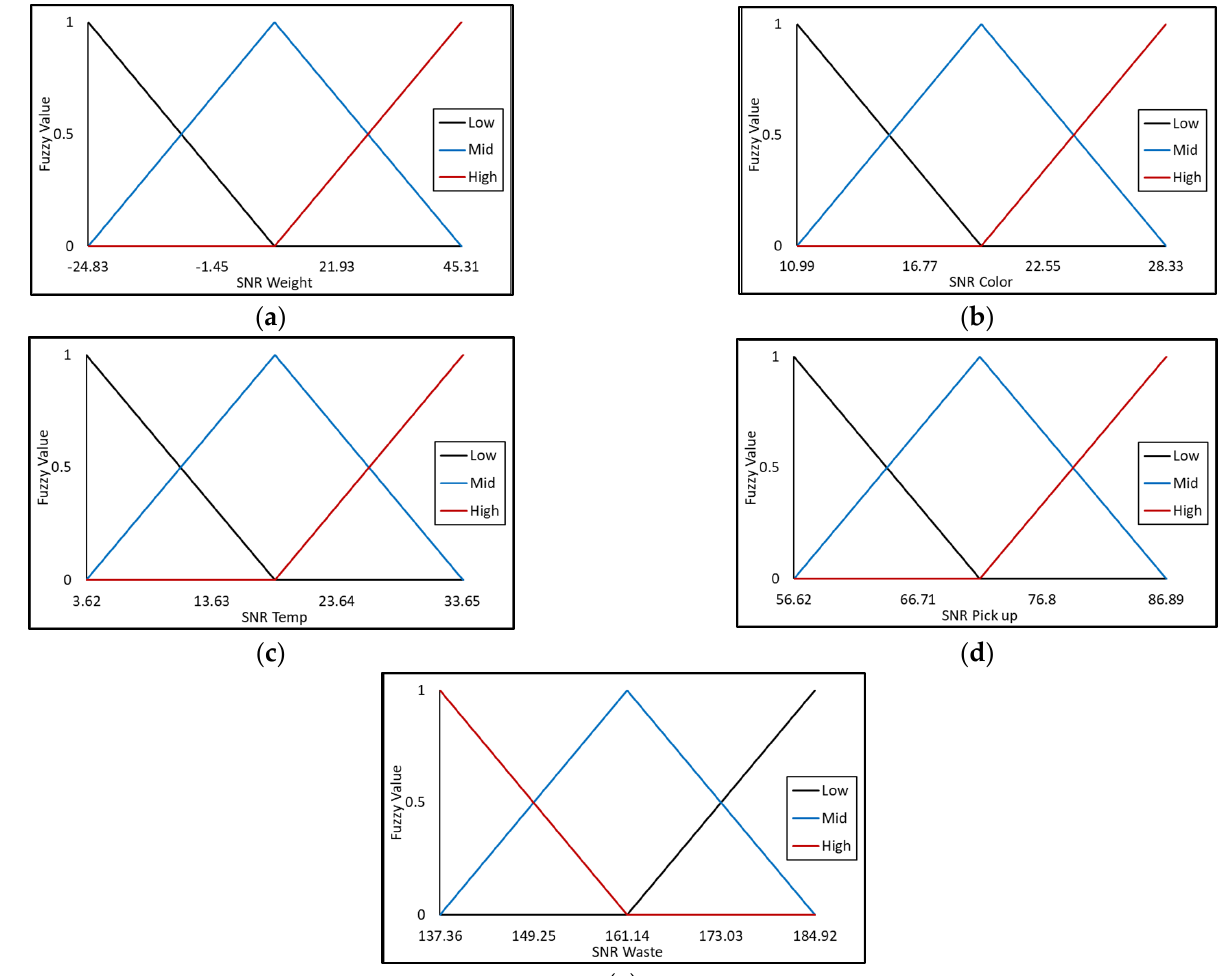
Table 10. the largest and smallest values in High, Mid and Low MFs of SNR for each response.